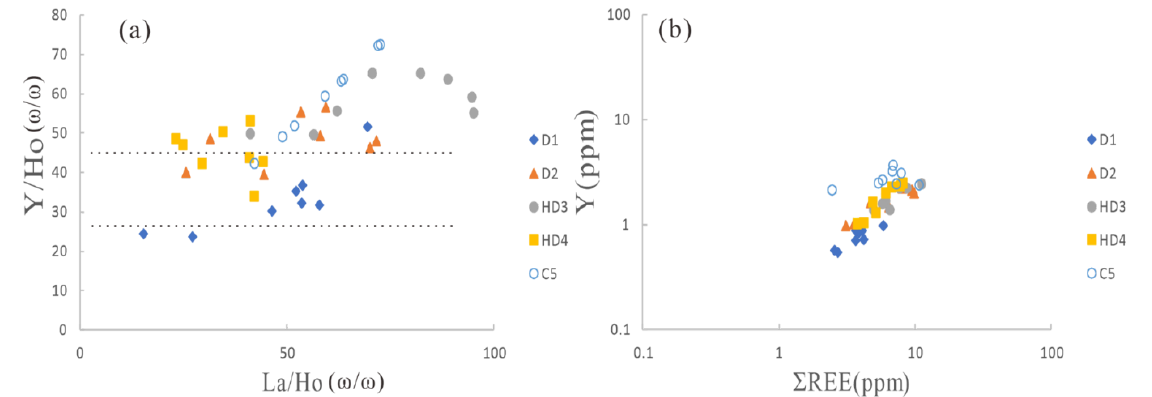
Figure 8. La/Ho vs. Y/Ho ( a ) and Y vs. ∑REE ( b ) diagrams for dolomite from the Fuli Pb-Zn